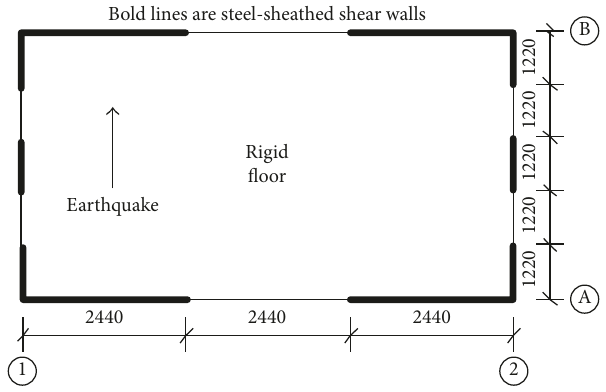
Figure 1: Plan view of a 2-story steel-sheathed CFSF